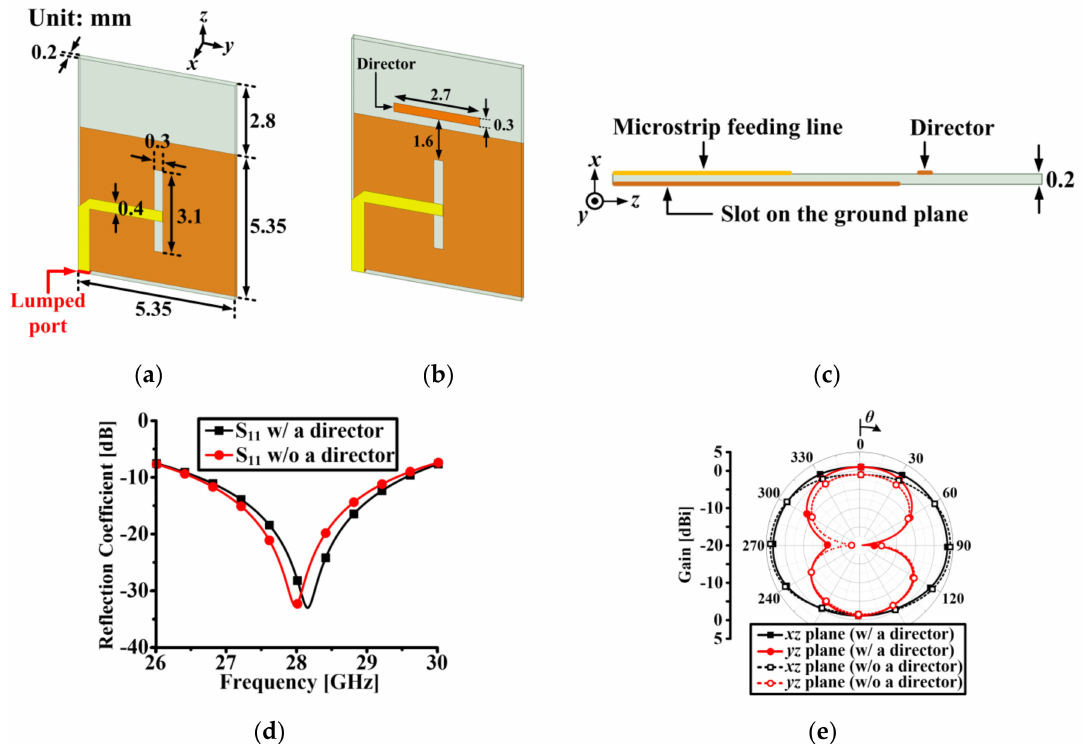
Figure 2. Single slot radiator: ( a ) without a director, ( b ) with a director, ( c ) side view, ( d ) simulated reflection coe ffi cients, and ( e ) simulated radiation patterns at 28